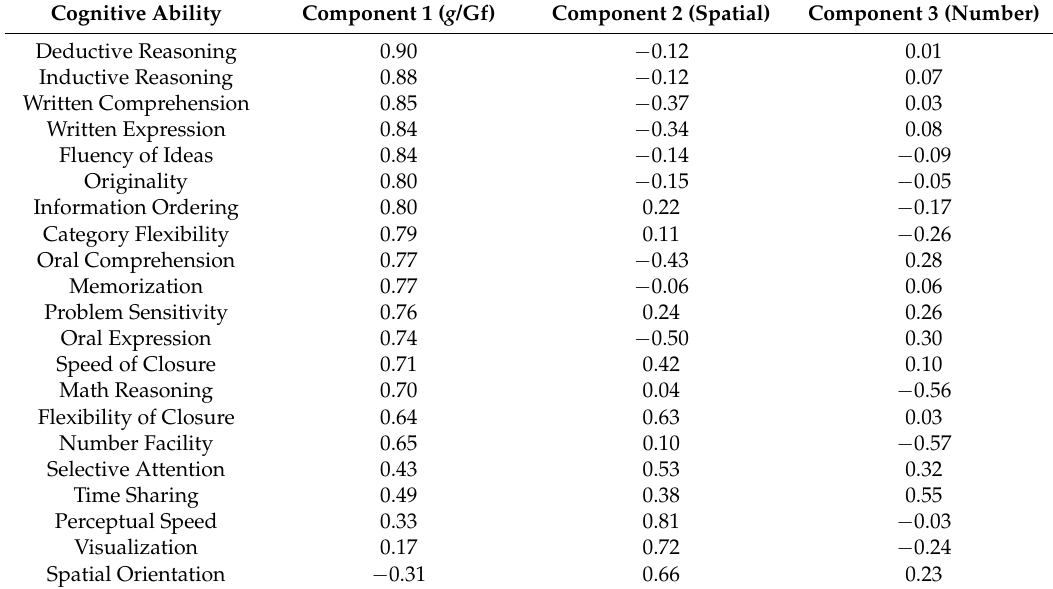
Table 1. Principal components loadings of the 23 cognitive abilities (Mean Importance